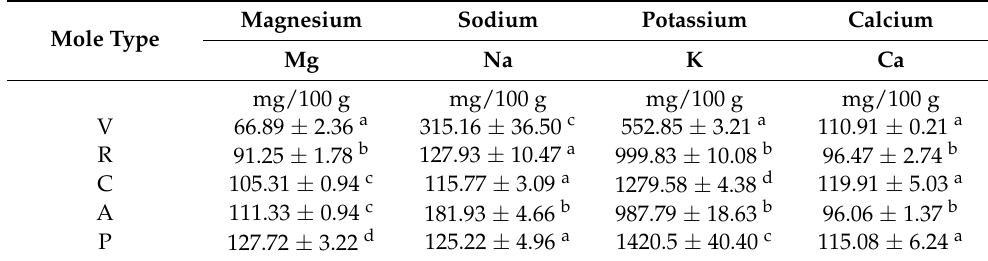
Table 5. Mineral content in five mole types from Hidalgo state,